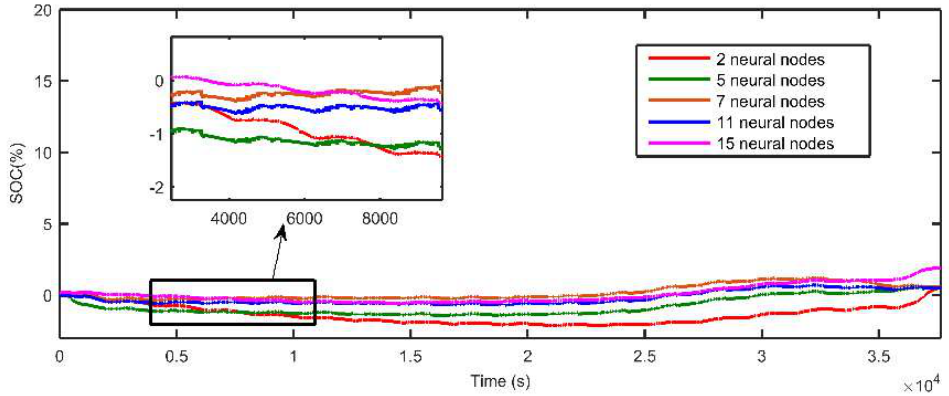
Figure 14. Comparison of SOC estimation based on non-linear observer and EKF in dynamic condition test 1 under random SOC initial value.